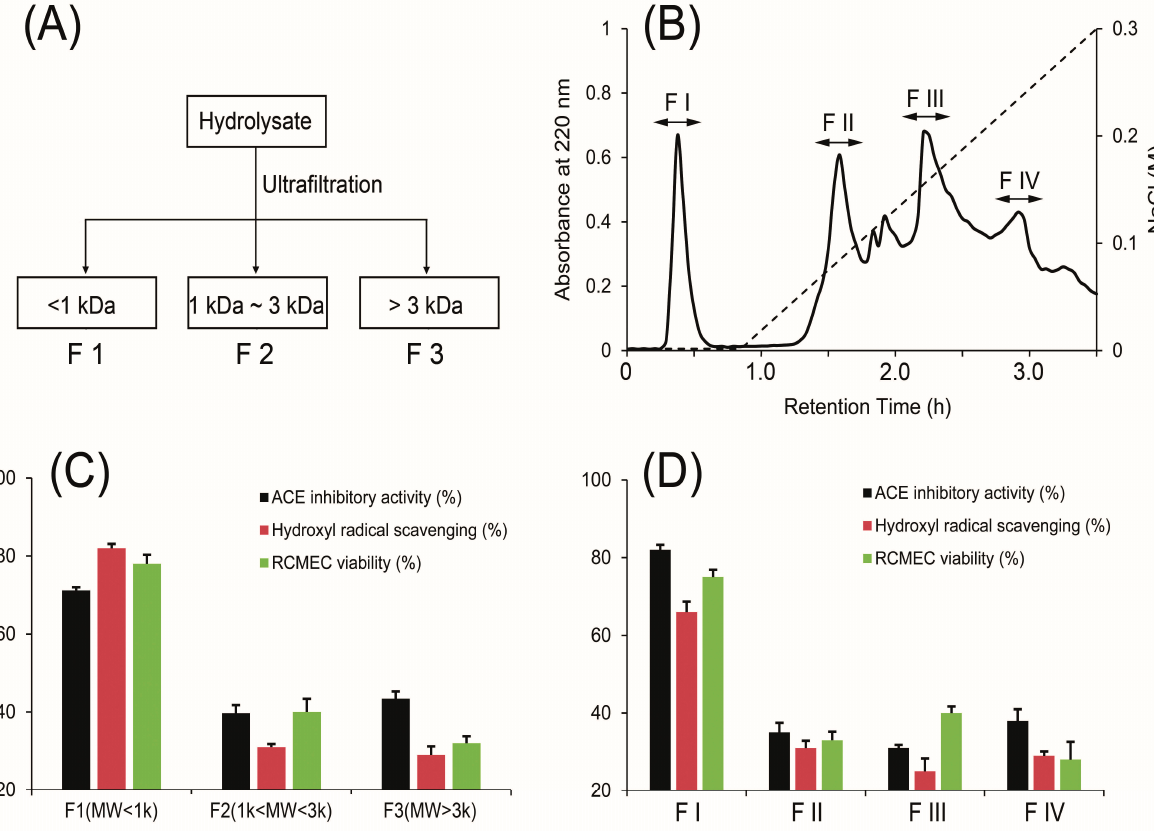
Figure 1. ( A ) Separation of peptides from R. esculentum hydrolysate via ultrafiltration. ( B ) Anion exchange chromatogram of F1 obtained by ultrafiltration on a DEAE Sepharose Fast Flow. ( C ) ACE inhibitory and antioxidant activities (hydroxyl radical scavenging activity and protection of rat cerebral microvascular endothelial cell (RCMEC) against H O ) of F1, F2 and F3. ( D ) ACE inhibitory and antioxidant activities (hydroxyl radical 2 2 scavenging activity and protection of RCMEC against H